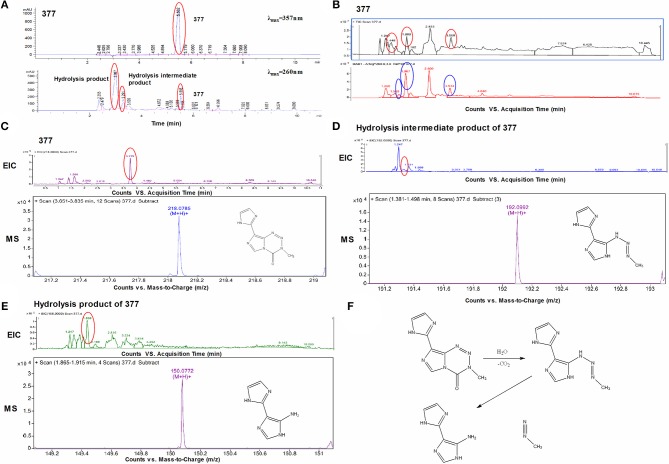
Decomposition of C8-imidazotetrazine analog 377. (A) Chromatogram of 377 by HPLC. (B) Total ion chromatogram of 377 by UPLC-Q-TOF/MS. (C) Mass spectra of 377 (C8H7N7O) at m/z 218.0786. (D) Mass spectra of intermediate (C7H9N7) at m/z 192.0992. (E) Mass spectra of metabolite (C6H7N5) at m/z 150.0772. (F) Reaction scheme for the decomposition of 377 in H2O.